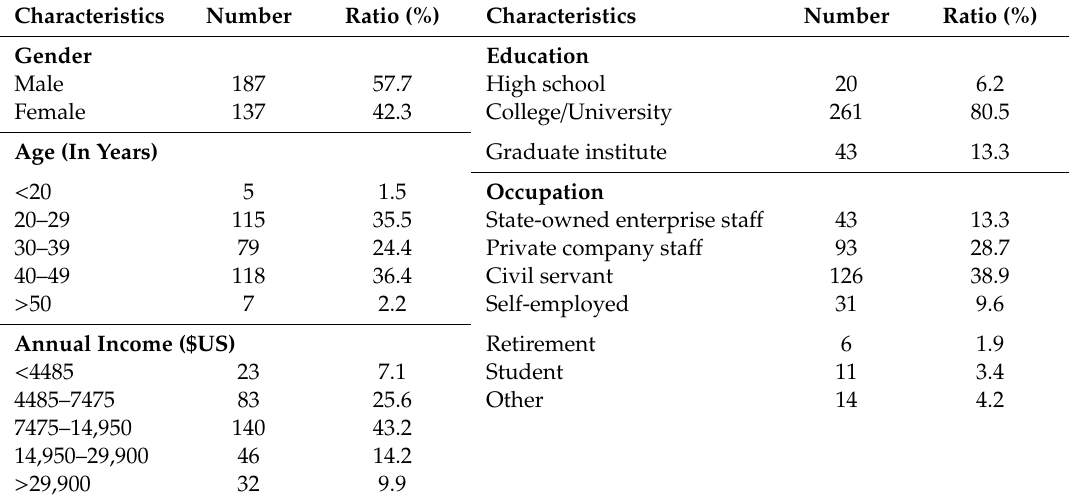
Table 1. Demographic